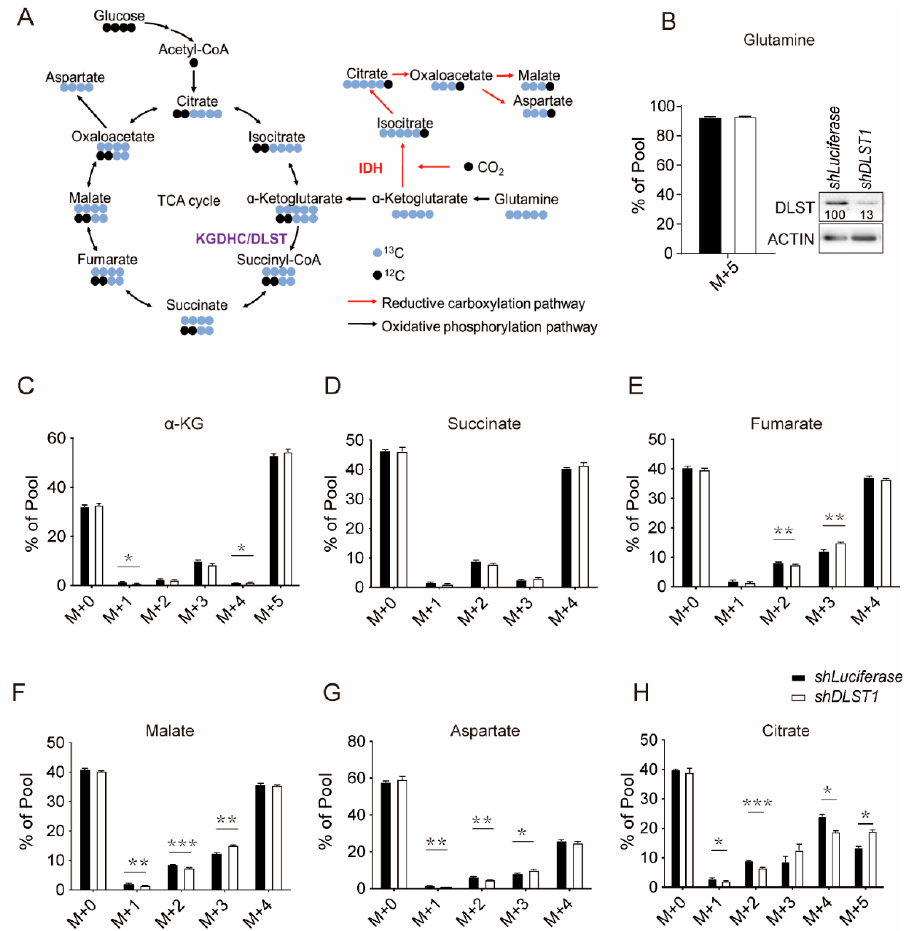
Figure 1. DLST inactivation increased reductive carboxylation while reducing TCA cycle intermediates in human T-ALL cells. ( A ) Scheme of 13 C labeled glutamine contribution to TCA cycle metabolites. ( B ) Percentage of 13 C-labelled glutamine uptake in human MOLT3 cells in the presence or absence of DLST knockdown. The insert in panel ( B ) shows efficient depletion of DLST by shDLST1 hairpin. ( C – H ) Percentages of TCA cycle metabolites derived from 13 C labeled glutamine in the presence or absence of DLST knockdown. M stands for mass. The labels for M + 0, M + 1, M + 2, M + 3, M + 4, and M + 5 indicate that no or one to five carbons in the metabolite are derived from 13 C labeled glutamine. The data are presented as the mean ± s.e.m. and analyzed with an unpaired two-tailed t -test for statistical significance. * p < 0.05, ** p < 0.01, *** p < 0.001.